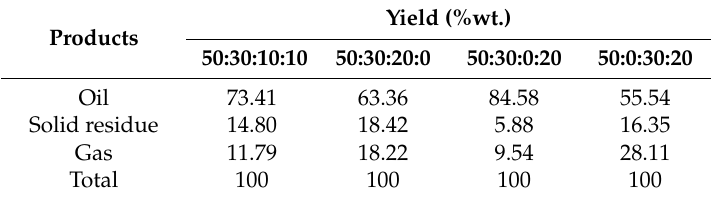
Table 6. Pyrolysis products yields for different temperature range (Prototype). Products Yield (%wt.)